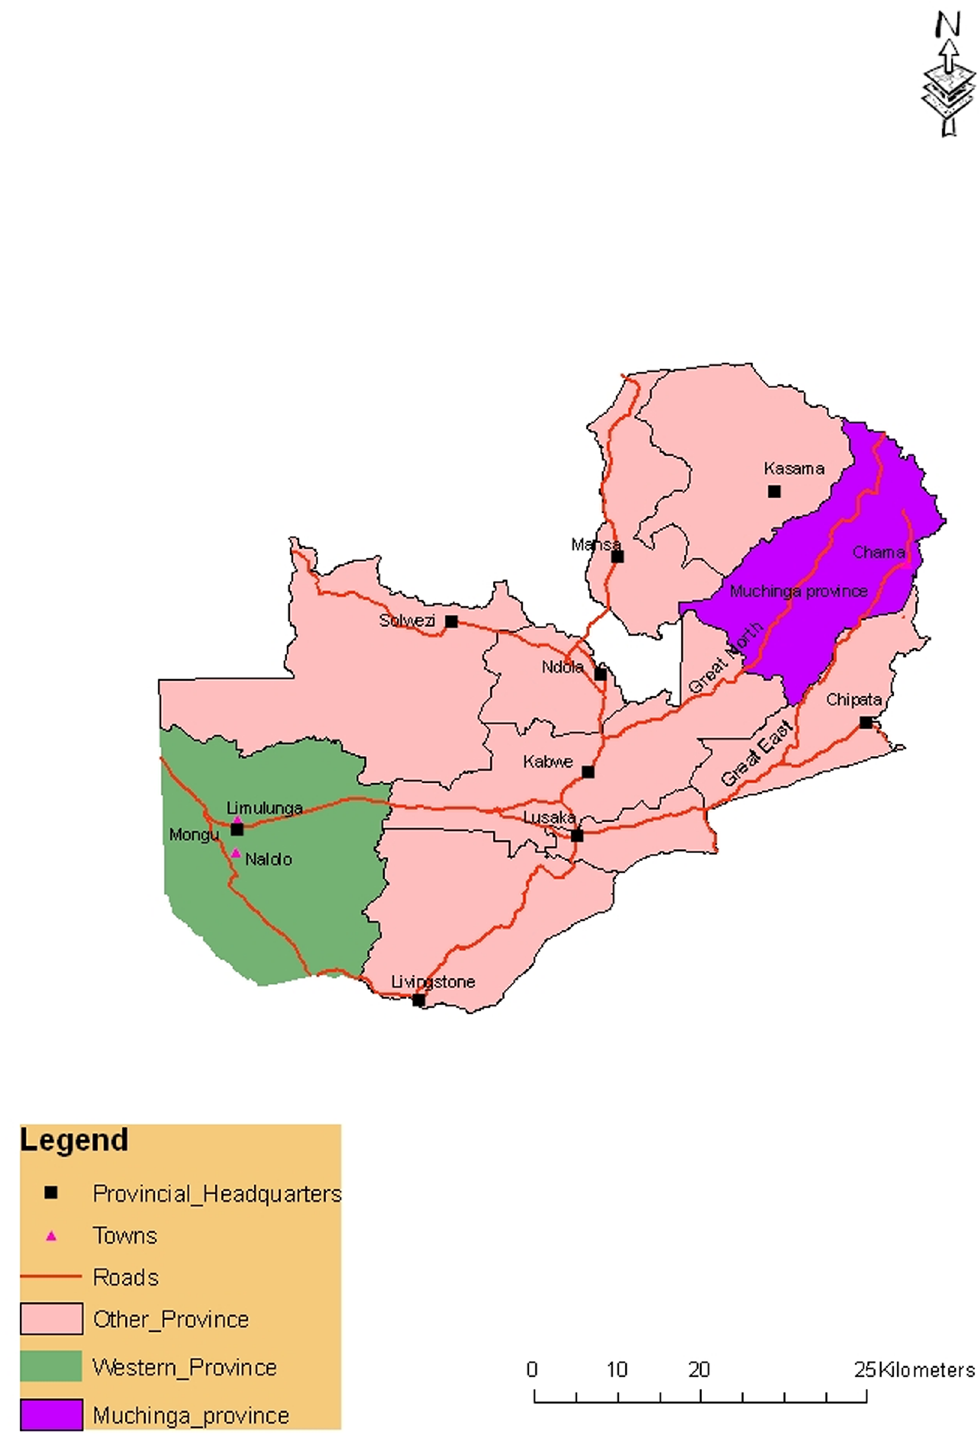
Fig 1. Map of Zambia showing study sites. Green color is Western provincewith Nalolo,Limulunga and Mongu districts. Purple color is Muchingaprovincewith Chama district.